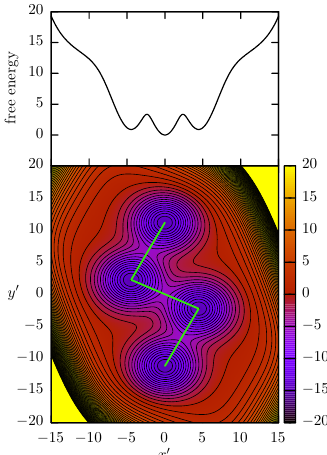
Figure 5. PES and its FEP along the rotated x (cid:48) coordinate. To facilitate the vizualizing of the free-energy projection, x (cid:48) coordinate is align in the horizontal axis.